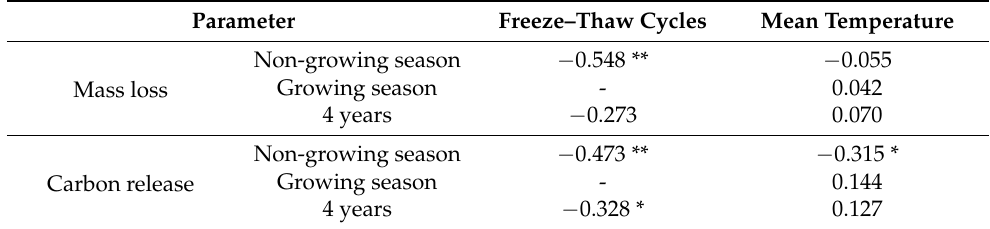
Table 3. Spearman correlation coefficient between mass loss, carbon release and environmental factors in the non-growing season, growing season and the 4 total decomposition years. Significant correlations are indicated in a bold font, with * p < 0.05, ** p <